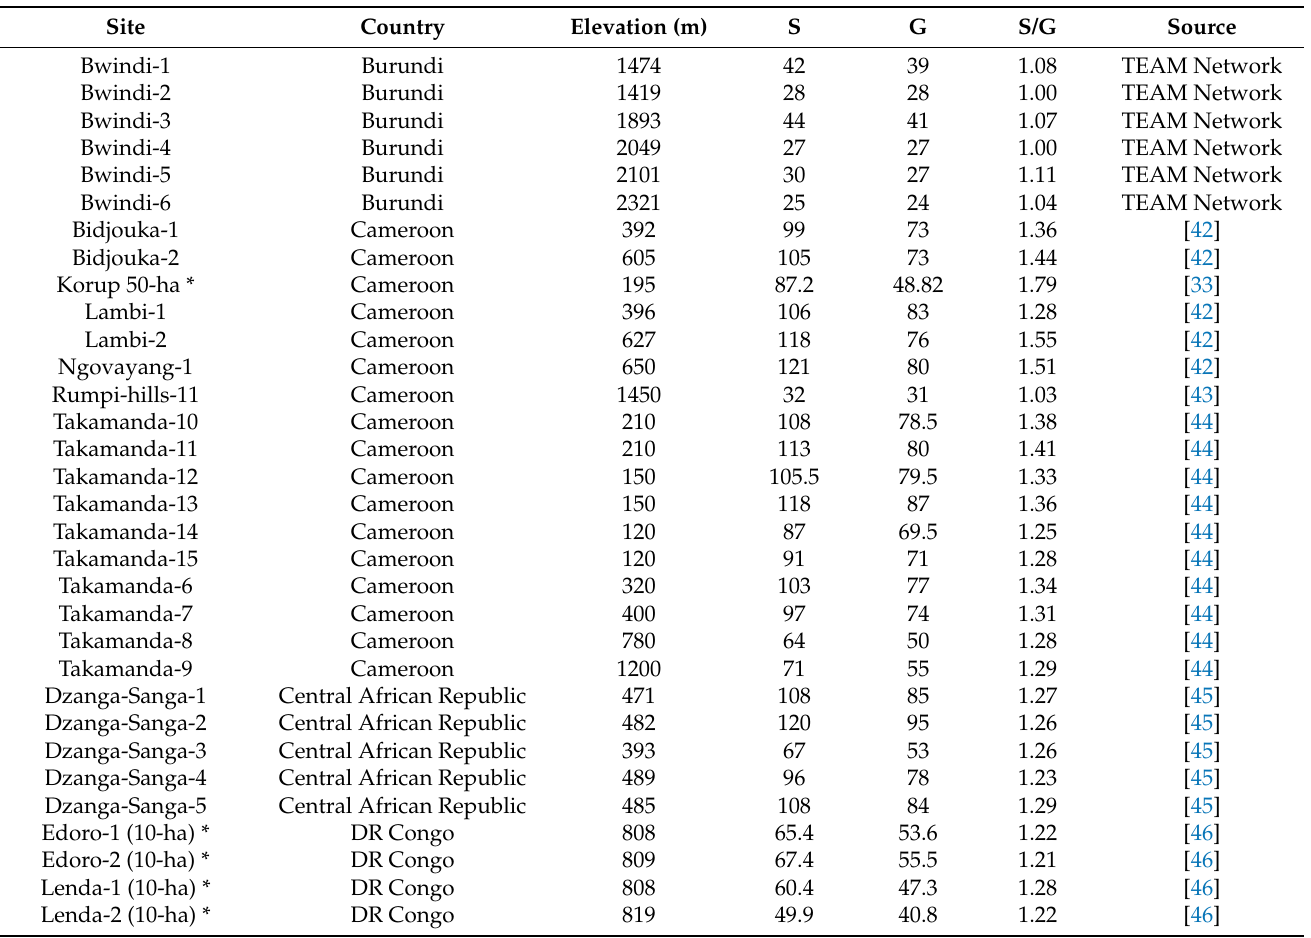
Table A1. Species-to-Genus ratio (S/G) among 43 African forest 1-ha plots for trees with dbh ≥ 10 cm. * denote large plots (10–50 ha) of the Forest Global Earth Observatory (ForestGEO) network. The data for each large plot was obtained by averaging the values in 1-ha subplots within the plot. S = number of species, G = number of genera. TEAM = Tropical Ecology Assessment and